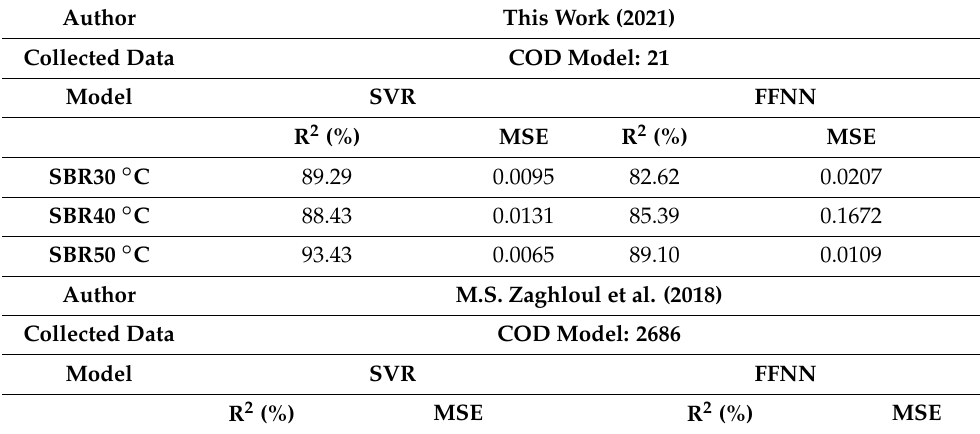
Figure 8. Model development for training and testing of SVR and FFNN for SBR30 °C, 40 °C, and 50 °C. Table 4. Comparison works between this work with previous work.